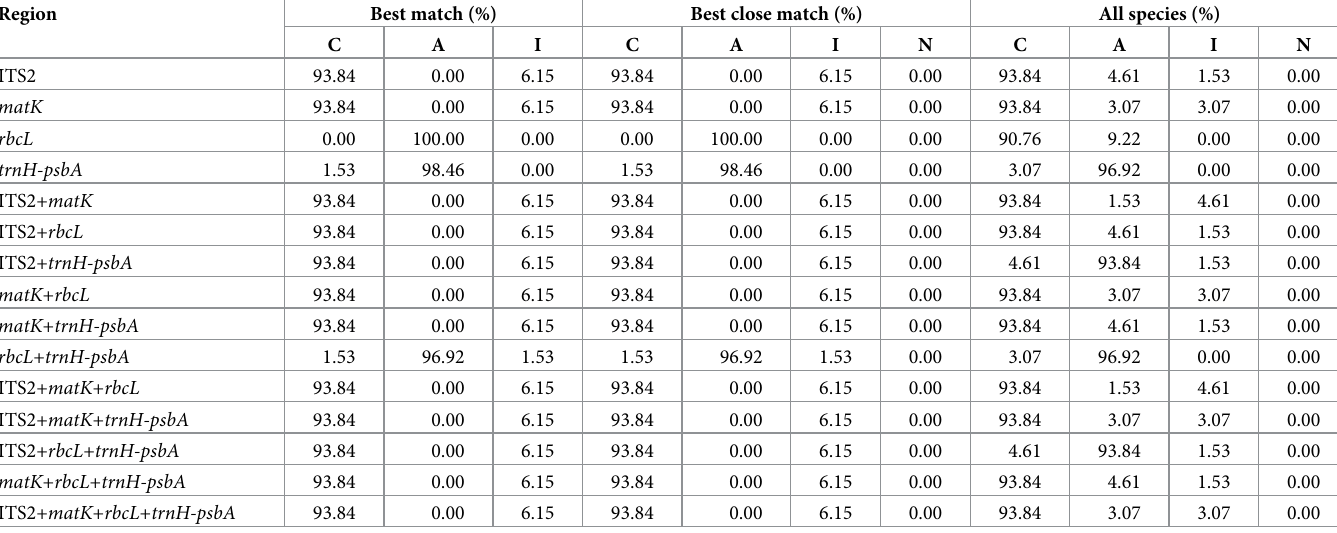
Table 3. Species identification success rate based on TaxonDNA analysis. C, A, I, and N represent correct, ambiguous, incorrect and no match, respectively. Region Best match (%) Best close match